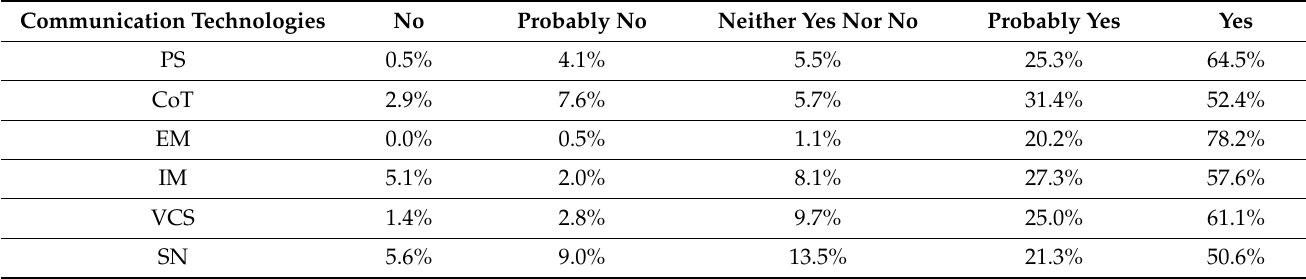
Table 16. Intention of future use of communication technologies by students. Communication